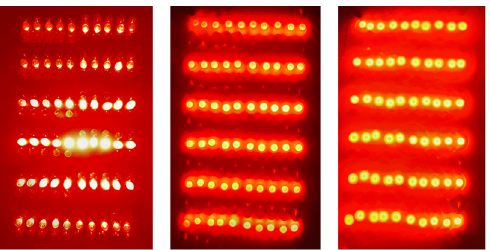
Figure 8. Illumination device switched on: infrared, red, and green light.